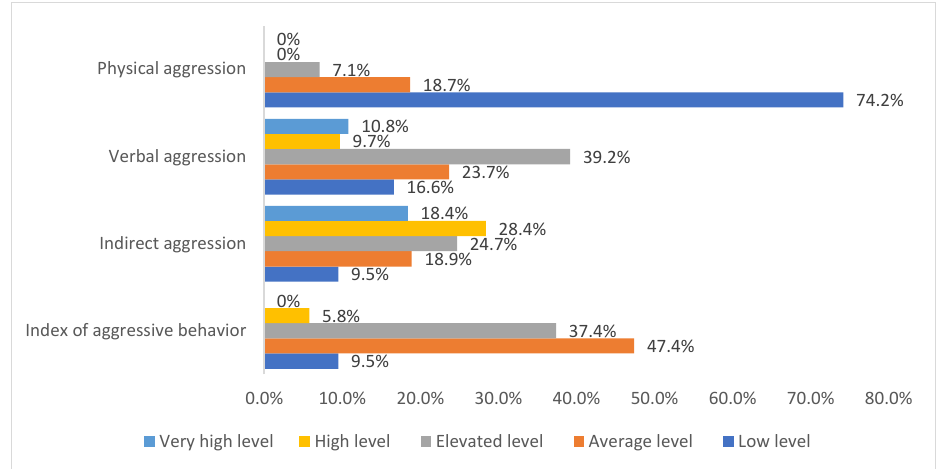
Figure 7. The frequency distribution of COVID-19 ICUs nurses by the levels of the components of aggression.